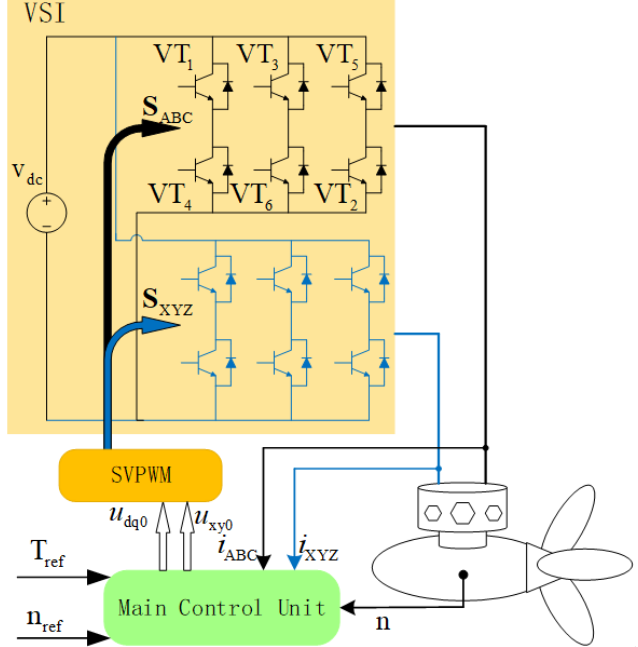
Figure 3. Driving Unit Topology of Marine Electric Propulsion System.